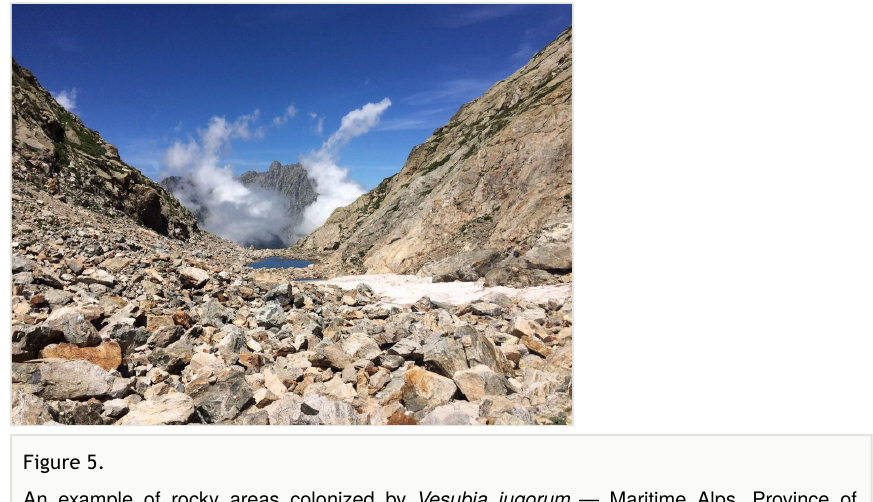
Figure 5. An example of rocky areas colonized by Vesubia jugorum — Maritime Alps, Province of Cuneo. [Photo credit: Filippo Milano,